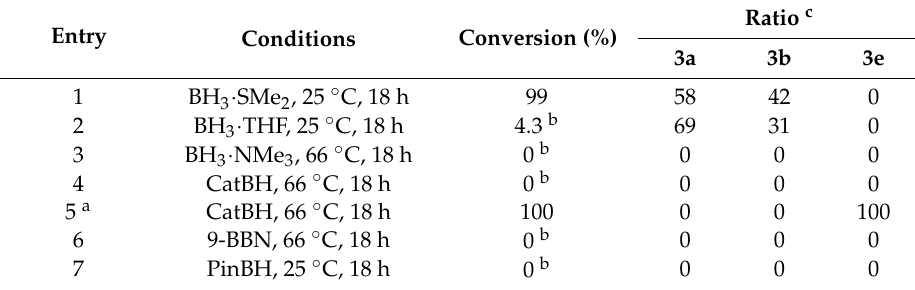
Table 1. Screening of different hydroboration reagents.